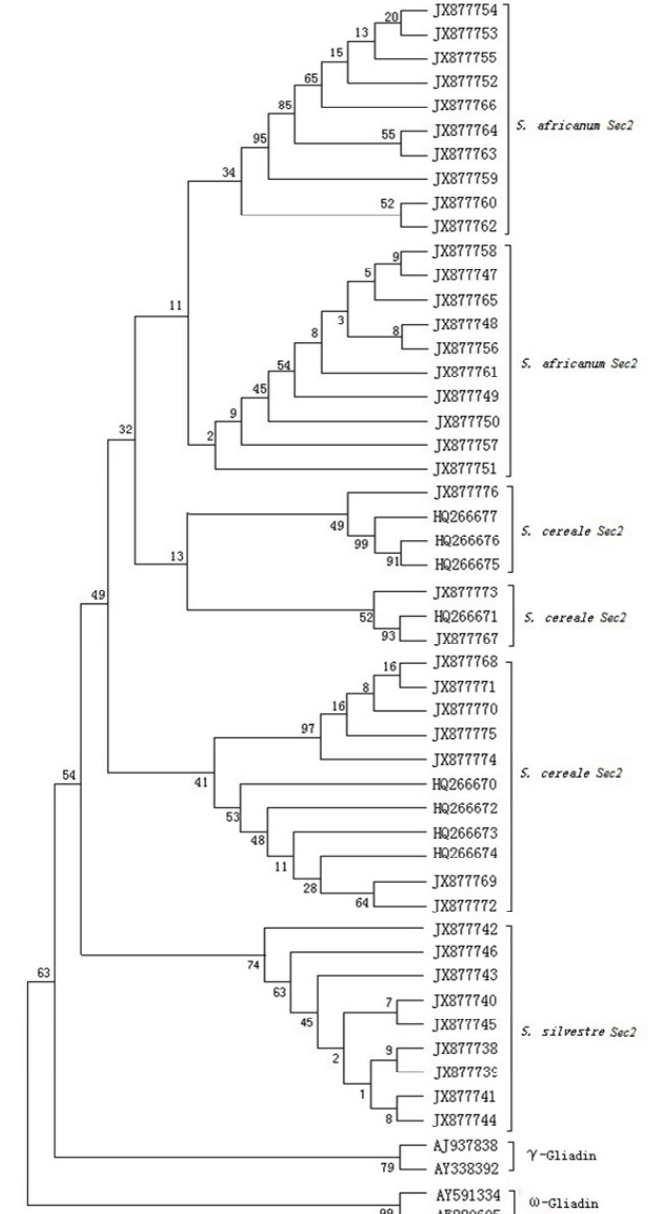
Figure 4. Phylogenetic tree generated from the Sec2 gene family from Secale and the control gliadin of wheat by MEGA4 using the neighbor-joining (NJ) method. Numbers above the branches show bootstrap frequencies based on 1000